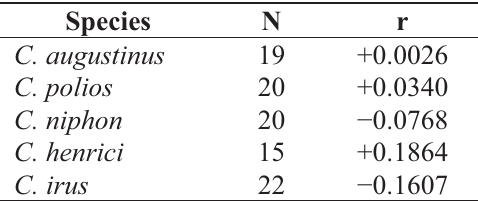
Table 4. Spearman rank correlation coefficients (r) of last observed date in central Wisconsin and year (trend over time), by species. None were statistically